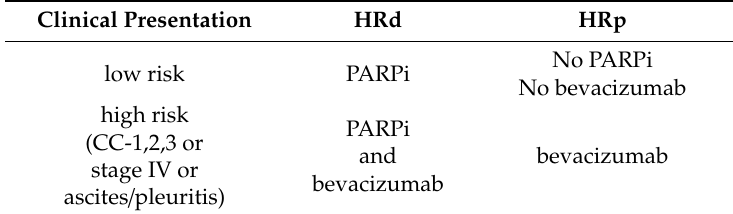
Table 3. Proposition of maintenance setting after standard of care chemotherapy in front-line in advanced serous ovarian